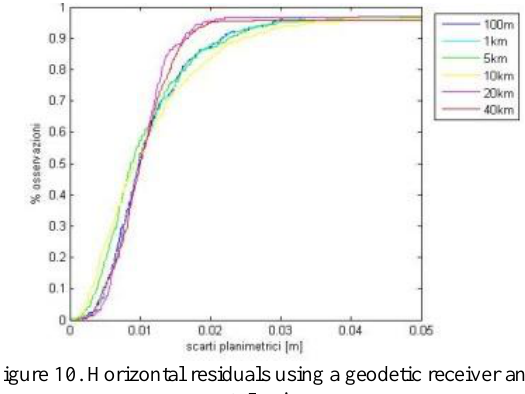
Figure 10. Horizontal residuals using a geodetic receiver and